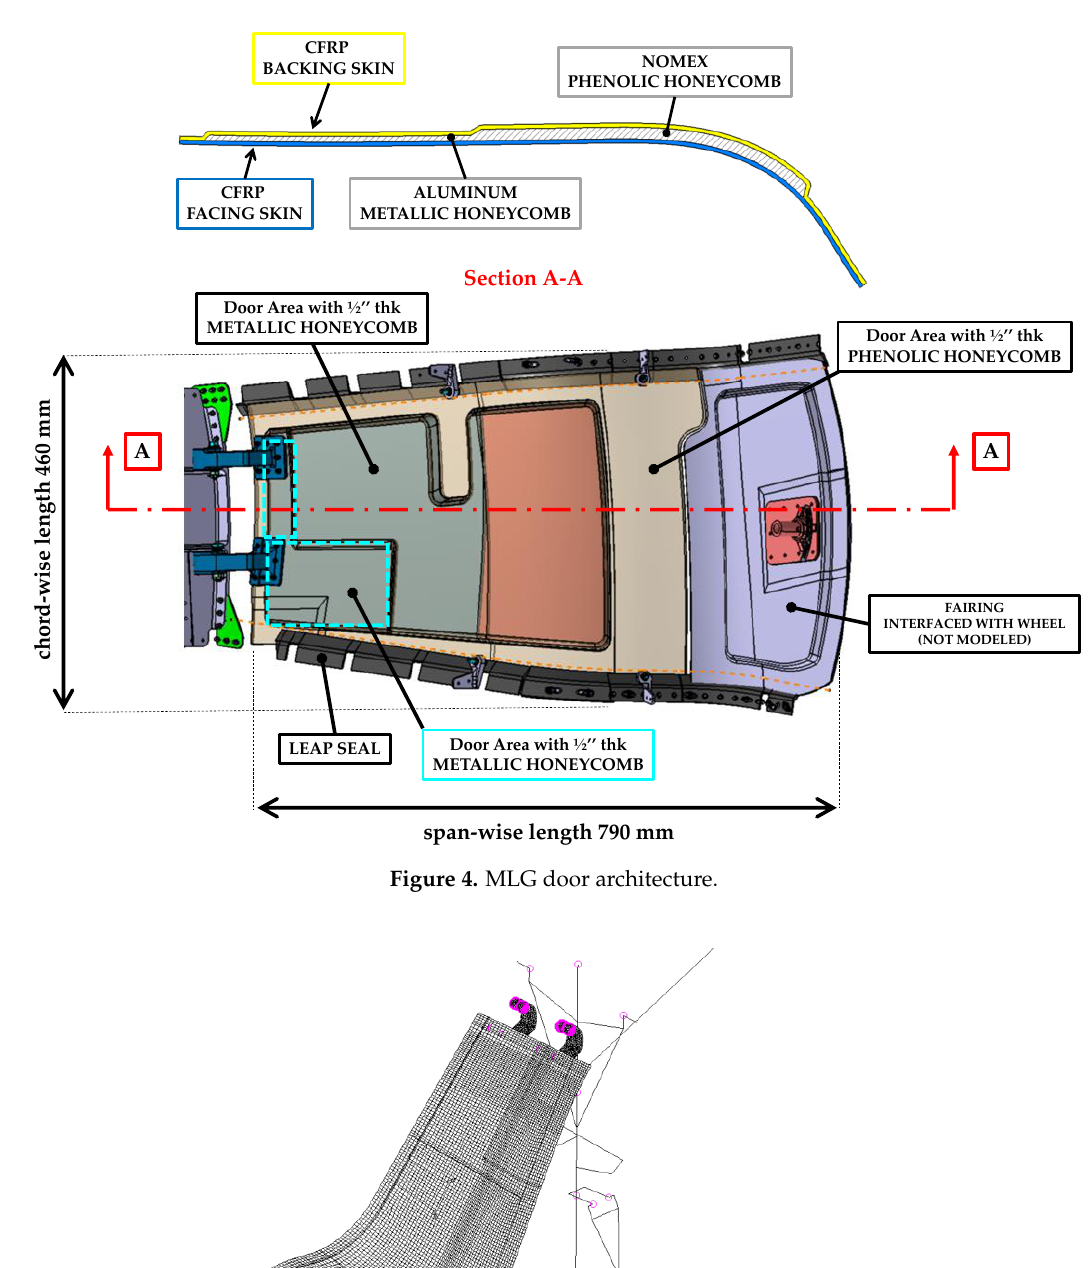
Figure 5. Global finite element (FE) model for dynamic analysis.